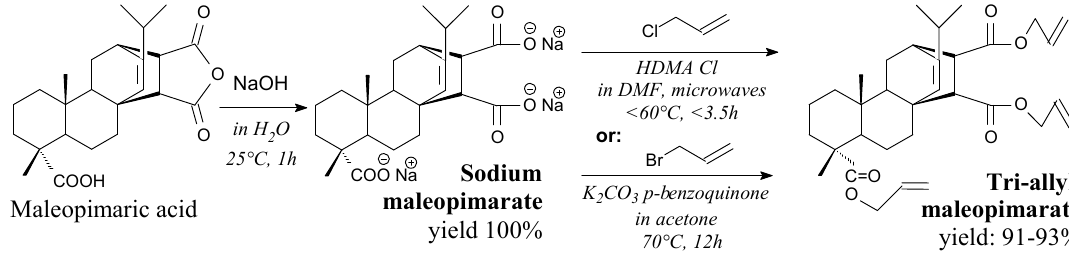
Scheme 18. Synthesis of triallyl